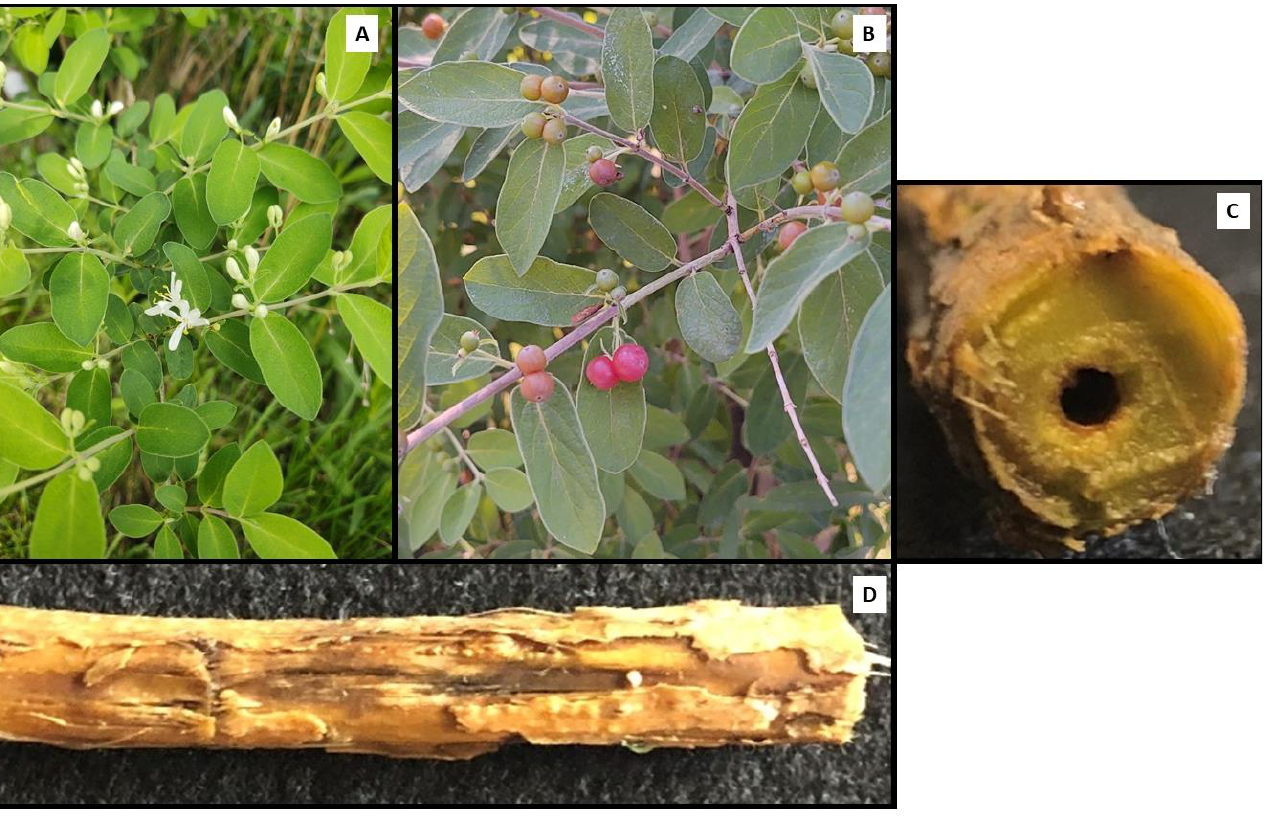
Figure 1. Images of the sequenced plant. ( A ) Leaves and flowers. ( B ) Opposite leaf pattern along stem and berries. ( C ) Transverse section of stem showing hollow structure. ( D ) Longitudinal section of stem.